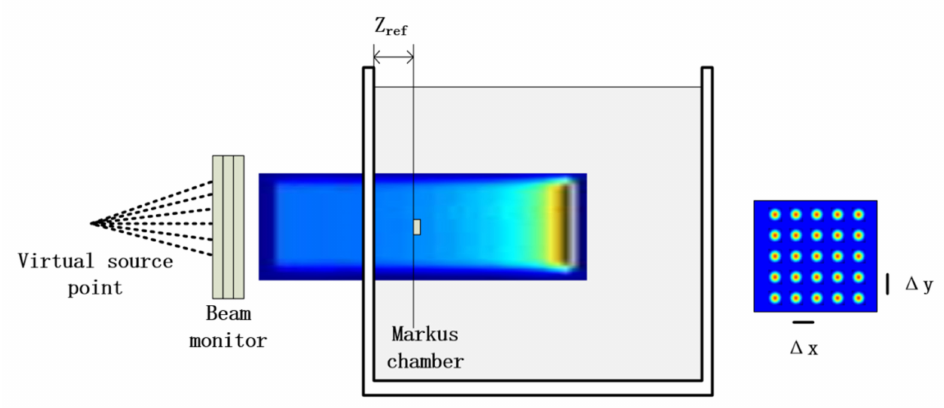
Figure 1. Illustration of the setup for the DAP measurement in water with the single-layer method. DAP measured with MC in a uniform field, DAP A